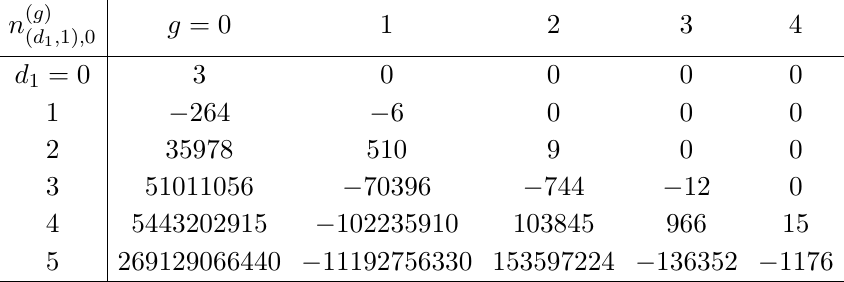
Table 25 . Base degree 1 Gopakumar-Vafa invariants for X (4)